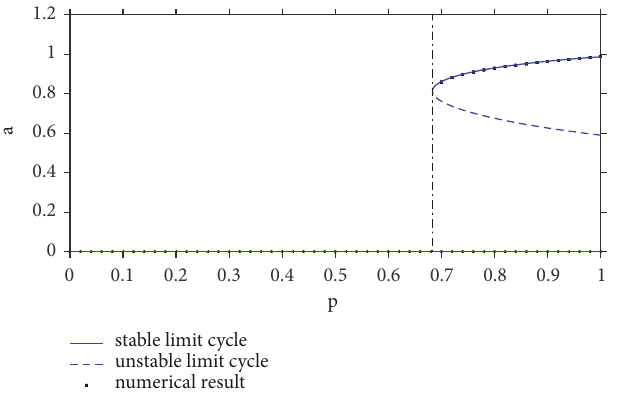
Figure 2: Bifurcation diagram of amplitude of system (28) at 𝐷 = 0